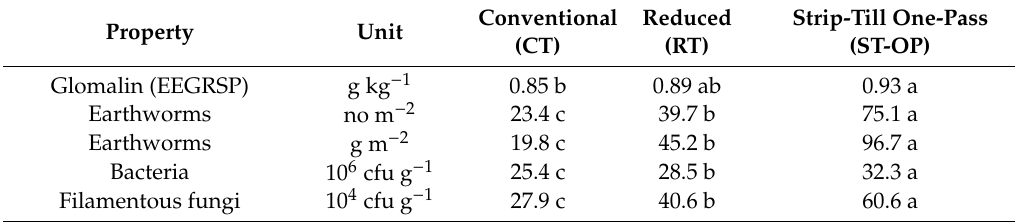
Table 4. Earthworms, microorganisms, and glomalin (EEGRSP) content in soil as a result of different tillage systems. Conventional (CT), reduced (RT), and strip-till one-pass (ST-OP). Property